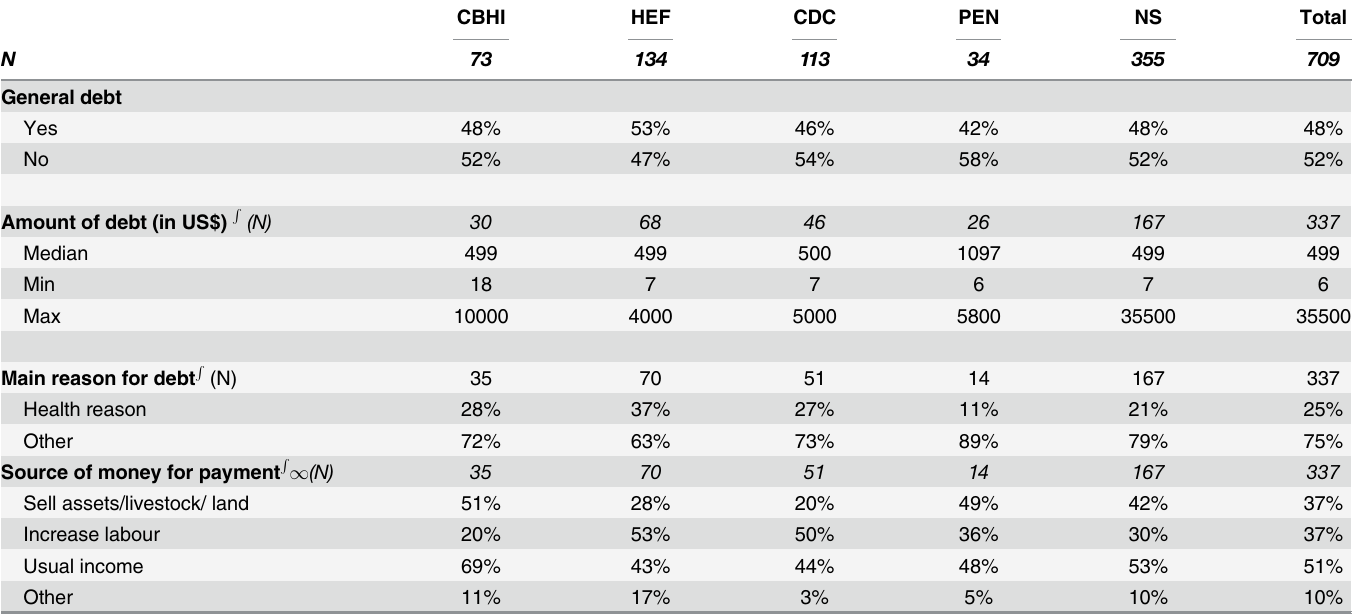
Table 9. Debt, debt for health and sources to